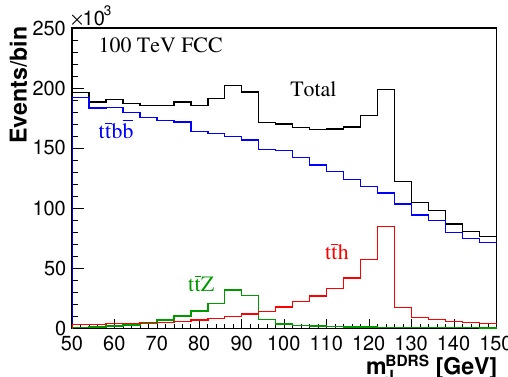
Figure 7 . The invariant mass distributions of the signal and background for the BDRS tagged fat-jet m BDRS J